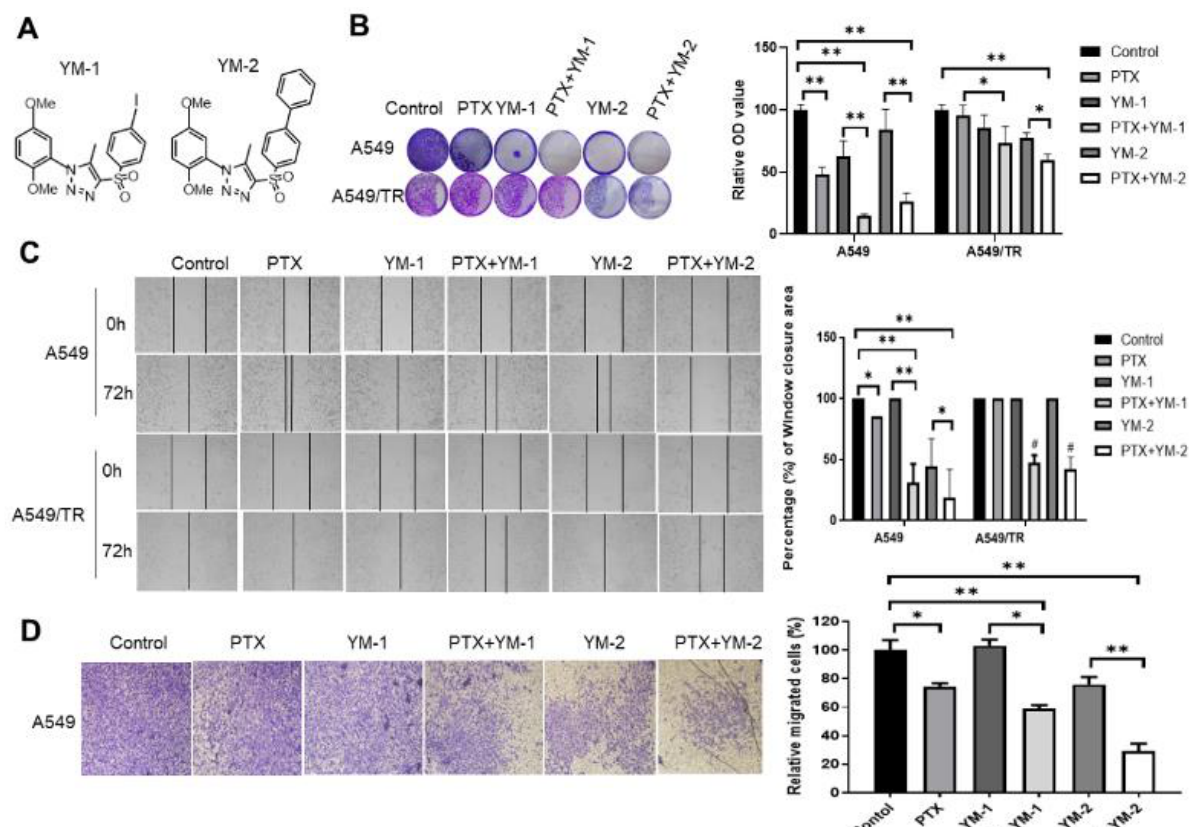
Figure 7. Two SPA70 derivatives also have synergistic effects with PTX in parental A549 and PTX-resistant A549/TR cells. ( A ) Chemical structure of two SPA70 derivatives YM-1, YM-2. ( B ) Representative pictures of the colonies in different groups, and the quantification of A549, A549/TR cells was shown as a bar graph ( n = 3). A total of 1 nM PTX, and/or 5 µ M YM-1/YM-2, were applied in 12-well plates with triplicates for 8–10 days. Crystal violet-stained colonies were lysed in buffer and the absorbance was recorded at 490 nm. *, p < 0.05; **, p < 0.01, compared with indicated treatment groups. ( C ) In the wound healing assay, 2 nM PTX and/or 10 µ M YM-1/YM-2 were applied to the cells for 72 h. The migrated cells across the scratch line were recorded and quantified as shown in the right panel. *, p < 0.05; **, p < 0.01, compared with indicated treatment groups. The photographs were taken by microscopy (200 × ). ( D ) Transwell invasion assay was carried out to evaluate the inhibitory effects of YM-1 or YM-2 combined with PTX on cell invasion in parental A549 cells. The invaded cells were counted as Figure 2D. The photographs were taken by microscopy (200 × ). *, p < 0.05; **, p < 0.01, compared with indicated treatment